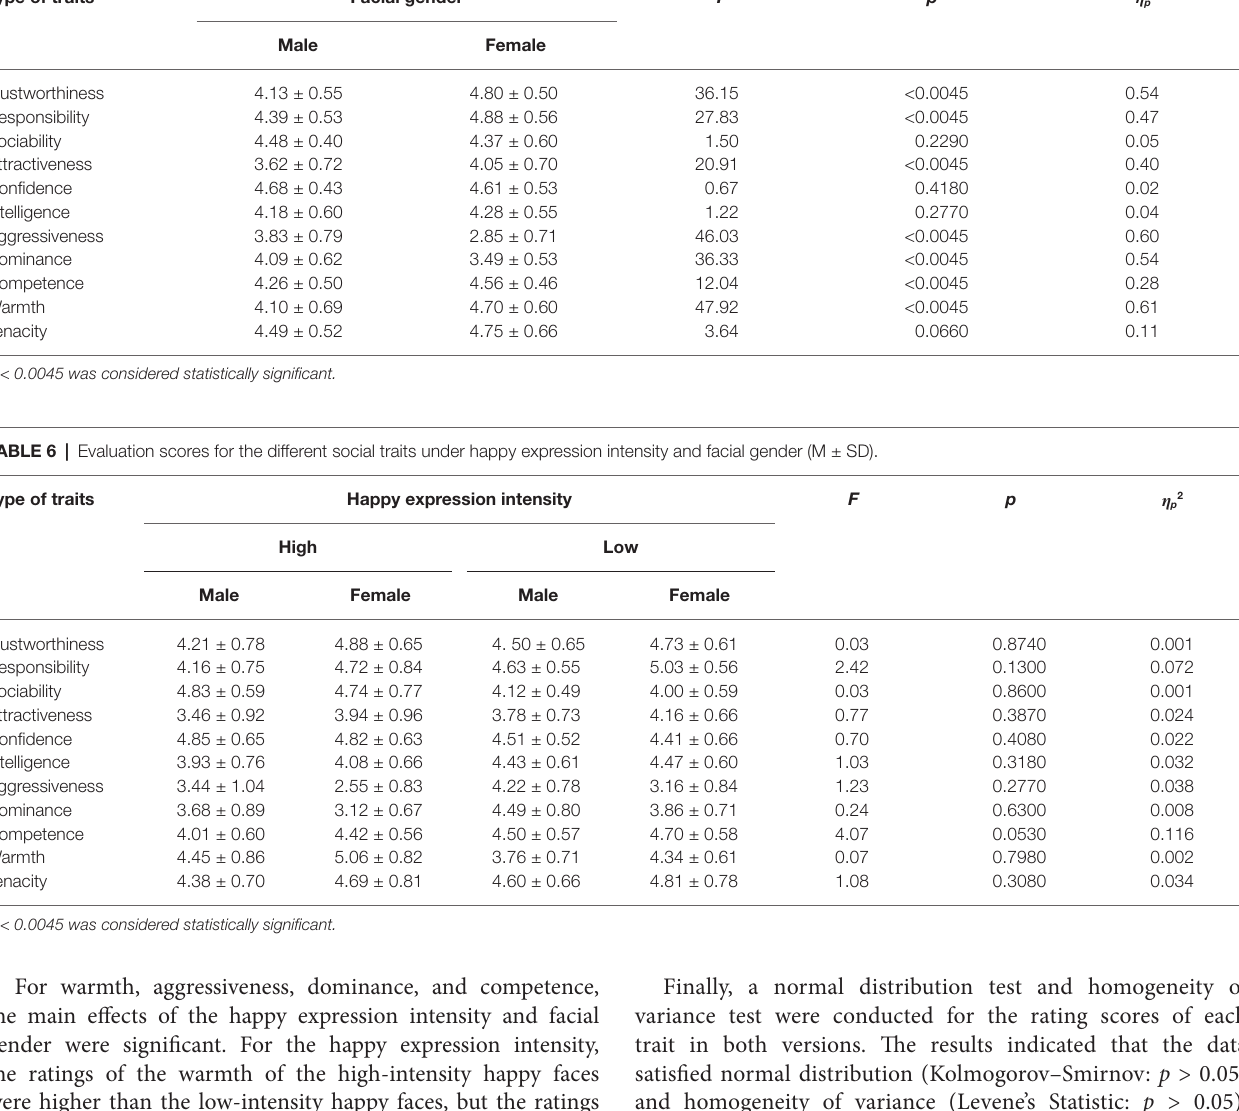
TABLE 5 | Evaluation scores for the different social traits under facial gender (M ± SD). Type of traits Facial gender